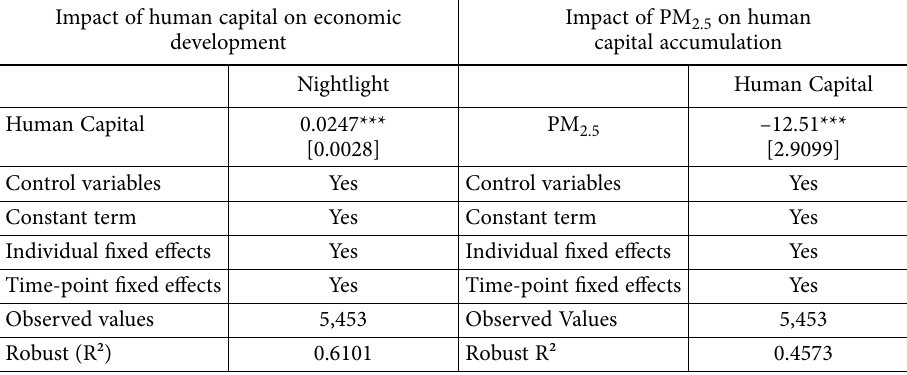
Table 7. Regression results for human